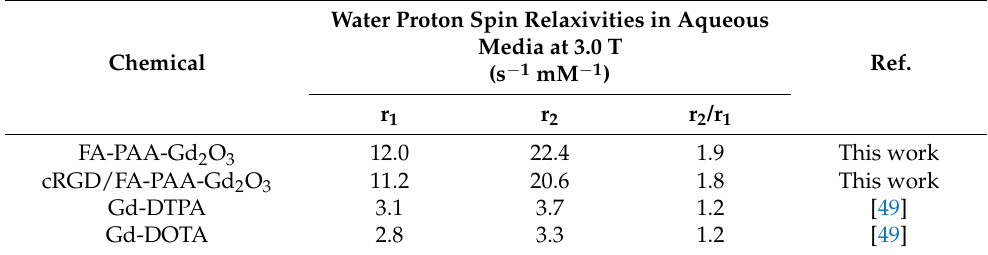
Figure 6. Nonlinear least-square fits to ( a-i ) the measured mean signal intensities at various TI values to obtain T 1 relaxation times and ( a-ii ) the mean signal intensities of multiple spin-echo measurements at various TE values to obtain T 2 relaxation times. ( b ) Plots of 1/T 1 and 1/T 2 inverse relaxation times as a function of Gd concentration for FA-PAA-Gd 2 O 3 and cRGD/FA-PAA-Gd 2 O 3 nanoparticles in aqueous media at H = 3.0 T and 22 °C. The slopes correspond to r 1 and r 2 values, respectively. ( c ) R 1 and R 2 map images showing dose-dependent contrast enhancements. Table 2. r 1 and r 2 values of FA-PAA-Gd 2 O 3 and cRGD/FA-PAA-Gd 2 O 3 nanoparticles.